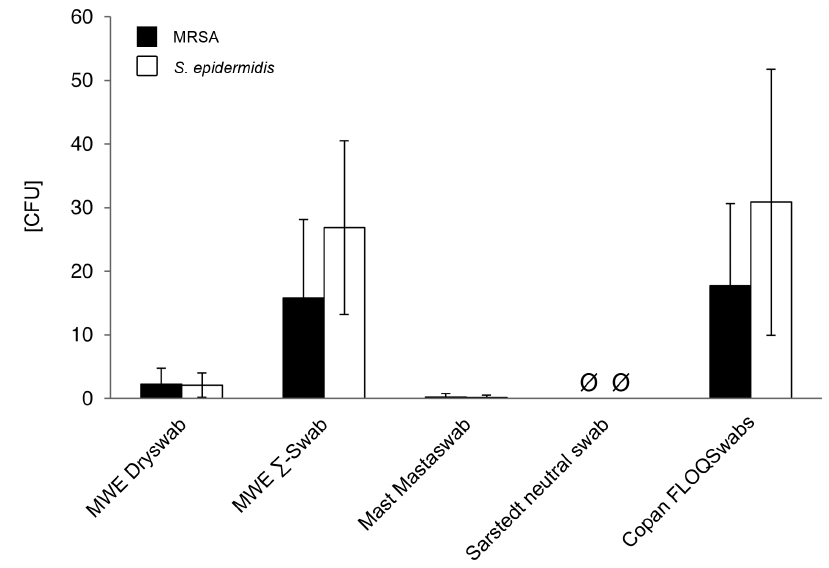
Figure 1. Recovery of bacteria in absolute numbers after direct plating. Viable counts of bacteria by direct plating of the displayed swab-types were determined by CFU counting as described in the methods section. CFU=colony forming units. Results from statistical analysis are shown in Table S1.